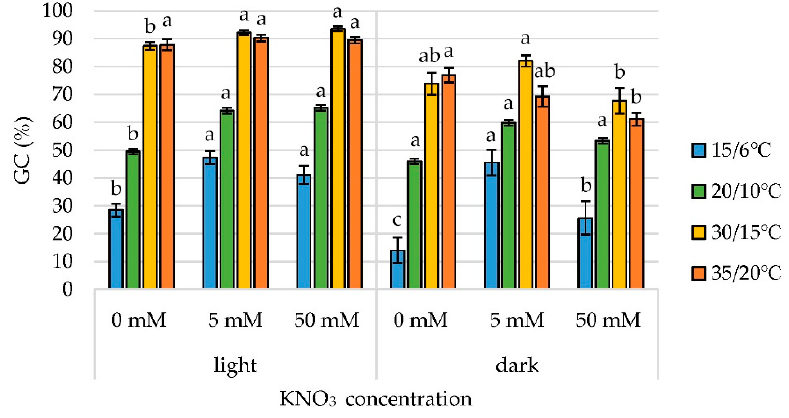
Figure 2. The effect of KNO 3 concentration, within the same temperature regime, on germinative capacity (GC) in light and dark treatments. Each value represents the mean ± SE for three repetitions. Mean values within light/dark treatment and same temperature with different letters differ significantly, p < 0.05.